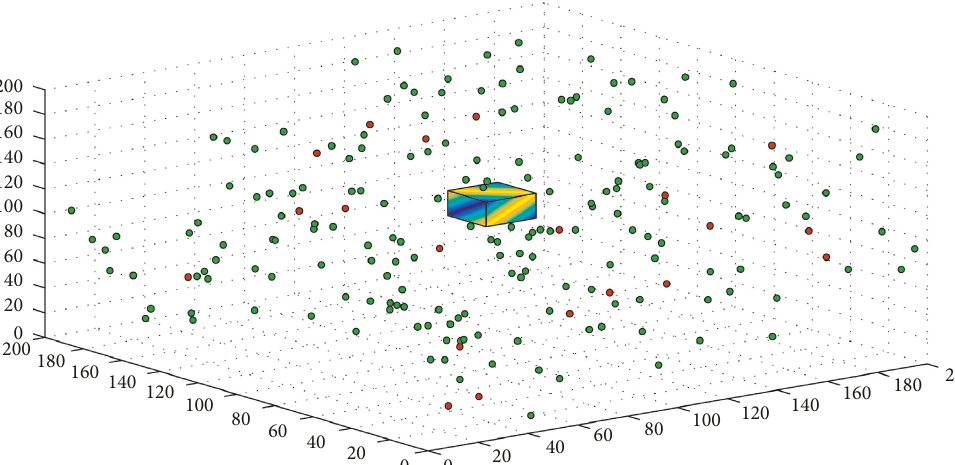
Figure 4: Distribution of node initial